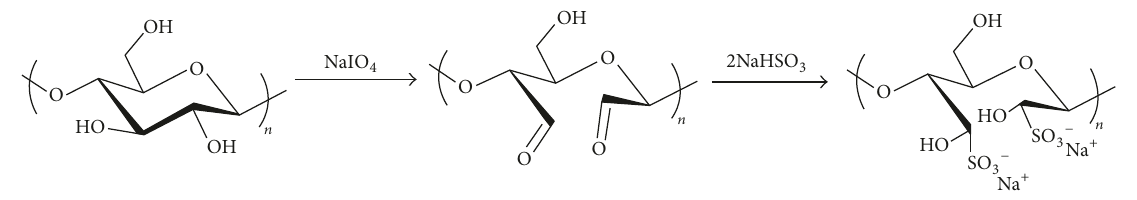
Figure 13: Schematic diagram of cellulose sulfonation via periodate-bisulfite